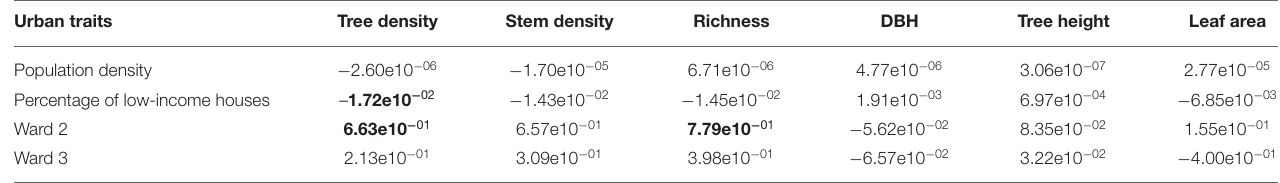
TABLE 5 | Multiple regression coefficients from GLM analyses using negative binomial distribution of canopy structure and cover as a function of urban traits at the plot level, numbers in bold represent regression coefficients with p -values < 0.001. Urban traits Tree